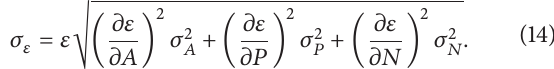
Polar angles Possible path lengths conditions